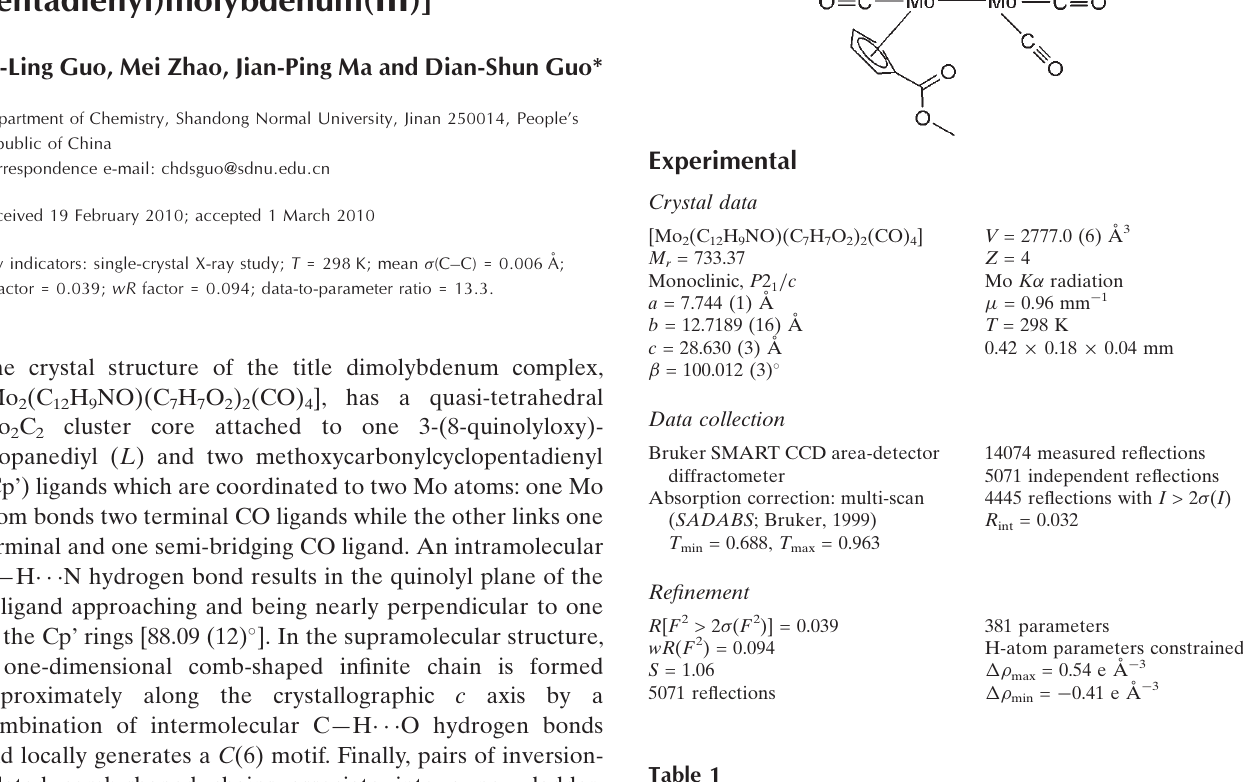
Data collection